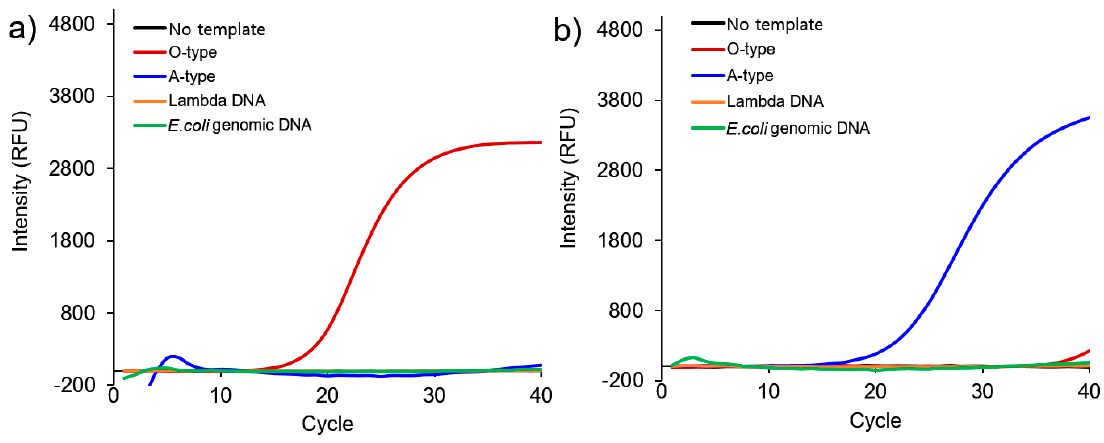
Figure 5. Specificity of nano-PCR with GO-AuNPs using O- and A-type specific primers and 10 ng of DNA templates. ( a ) O- and ( b ) A type-specific primers, respectively.